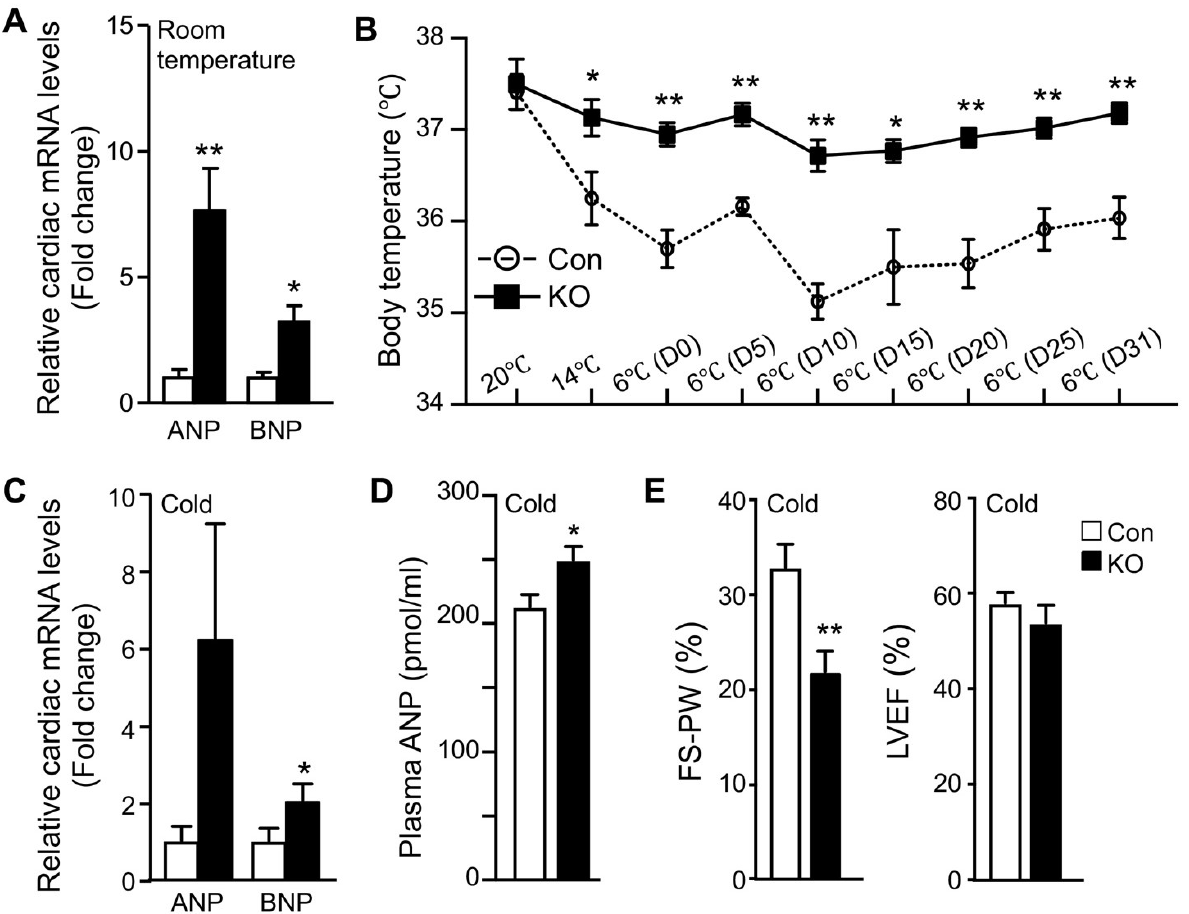
Figure 3. Adipose CGI-58 deficiency increases cardiac mRNA expression of natriuretic peptides and plasma ANP concentrations. ( A ) Relative mRNA levels of ANP and BNP in the hearts of 14-week-old HFD-fed mice housed at room temperature ( n = 4–5/group). ( B – E ) Body temperature changes ( B , n = 6–8), relative mRNA levels of natriuretic peptides ( C , n = 5), plasma concentrations of ANP ( D , n = 6–8), and echocardiography analysis ( E , n = 6–8) of the HFD-fed mice that were subjected to cold acclimation (2 °C/day reduction in housing temperatures) for 7 days, followed by 32 days of cold exposure at 6 C. * p < 0.05 and ** p < 0.01 vs. genotype by two-tailed unpaired Student’s t -test.